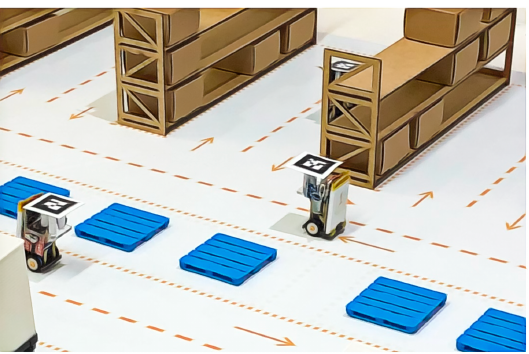
Figure 5. The ARENA, a small-scale warehouse, only with real elements [44] (© 2019 IEEE).